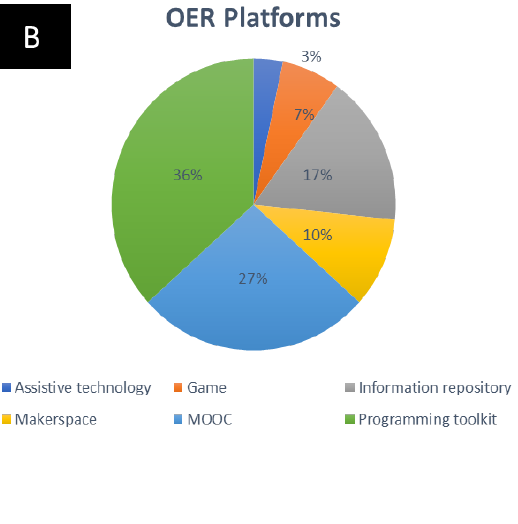
Research Types and OER Platforms in the Selected Articles